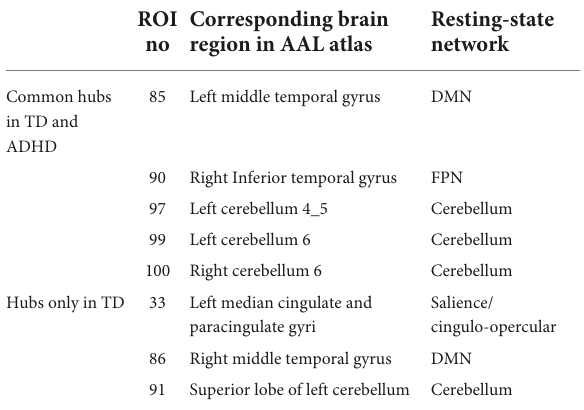
TABLE 5 The brain regions and resting-state networks related to hub nodes calculated based on Betweenness centrality in ADHD and TD